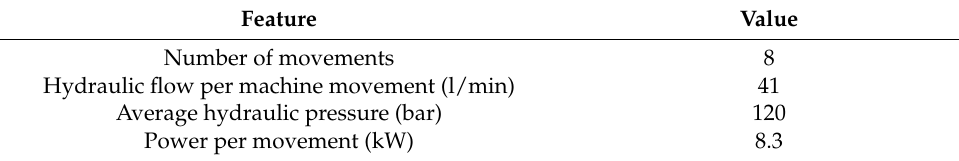
Table 19. Hydraulic bending cell’s main features necessary for the CF calculation [71].